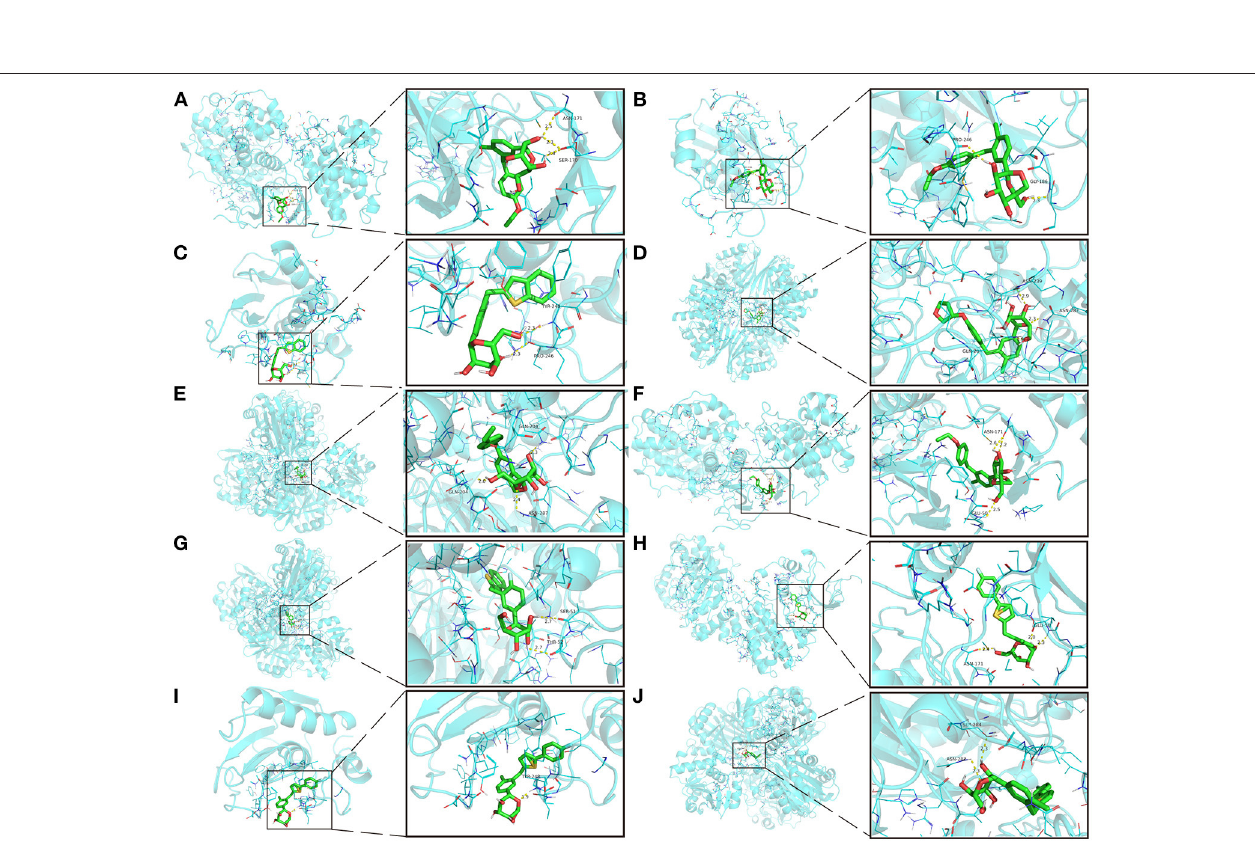
FIGURE 5 | The top 10 docking results. (A) Dapagliflozin-MAPK3; (B) Ertugliflozin-MMP9; (C) Ipragliflozin-MMP9; (D) Empagliflozin-GAPDH; (E) Tofogliflozin-GAPDH; (F) Ertugliflozin-MAPK3; (G) Ipragliflozin-GAPDH; (H) Canagliflozin-MAPK3; (I) Canagliflozin-MMP9; (J) Canagliflozin-GAPDH. The dashed lines in the graph are hydrogen bonds and the values are bond lengths. The names represent residues in the binding sites.